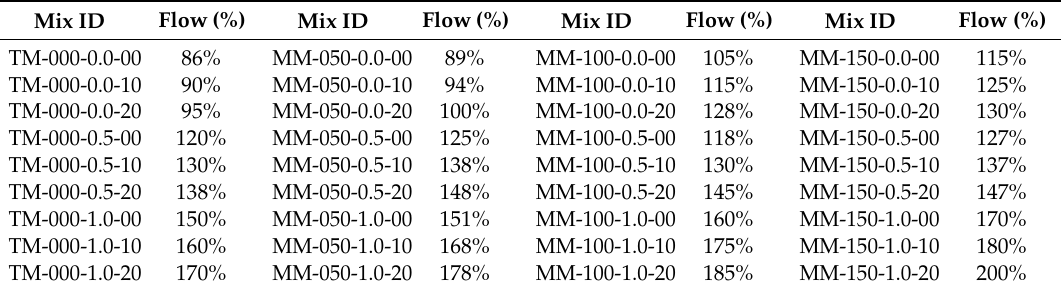
Table 6. Flow ratio of mortar mixes.